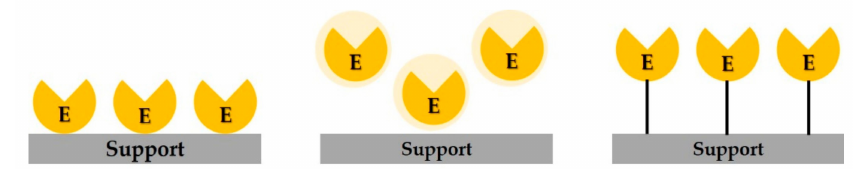
Figure 1. Enzyme immobilization techniques: ( left ) physical adsorption, ( middle ) entrapment ( right ) covalent bonding. E: